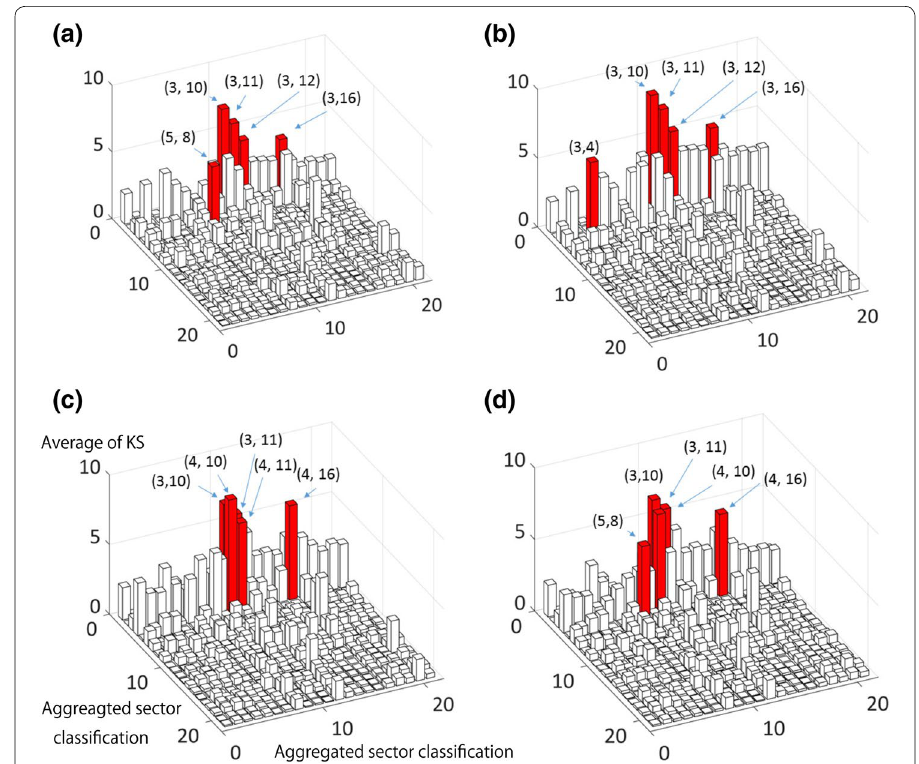
Fig. 2 Kernel structure matrices and their top 5 aggregated sectors in the years of a 1990, b 1995, c 2000, d 2005. The set number on the bars shows the number of aggregated sectors those are in the top 5 in each year. For plotting, values in the diagonal position and negative values are replaced with zero. 21 sector classifications aggregated from 379 sectors; 1. agriculture, forestry and fisheries; 2. metal mining; 3. ceramics and materials of earth and stones; 4. stone (non-ferrous stone); 5. coal, crude petroleum, and natural gas; 6. food and drink, fibers, and paper and pulp; 7. chemistry; 8. petroleum and coal products; 9. other commodities ; 10. cement; 11. other ceramic, stone, and clay products; 12. iron and steel; 13. machinery, equipment, and others; 14. transport vehicle; 15. other manufacturing; 16. construction; 17. electricity, gas, and water; 18. commerce, finance, and real estate; 19. transport; 20. information and communications; 21.